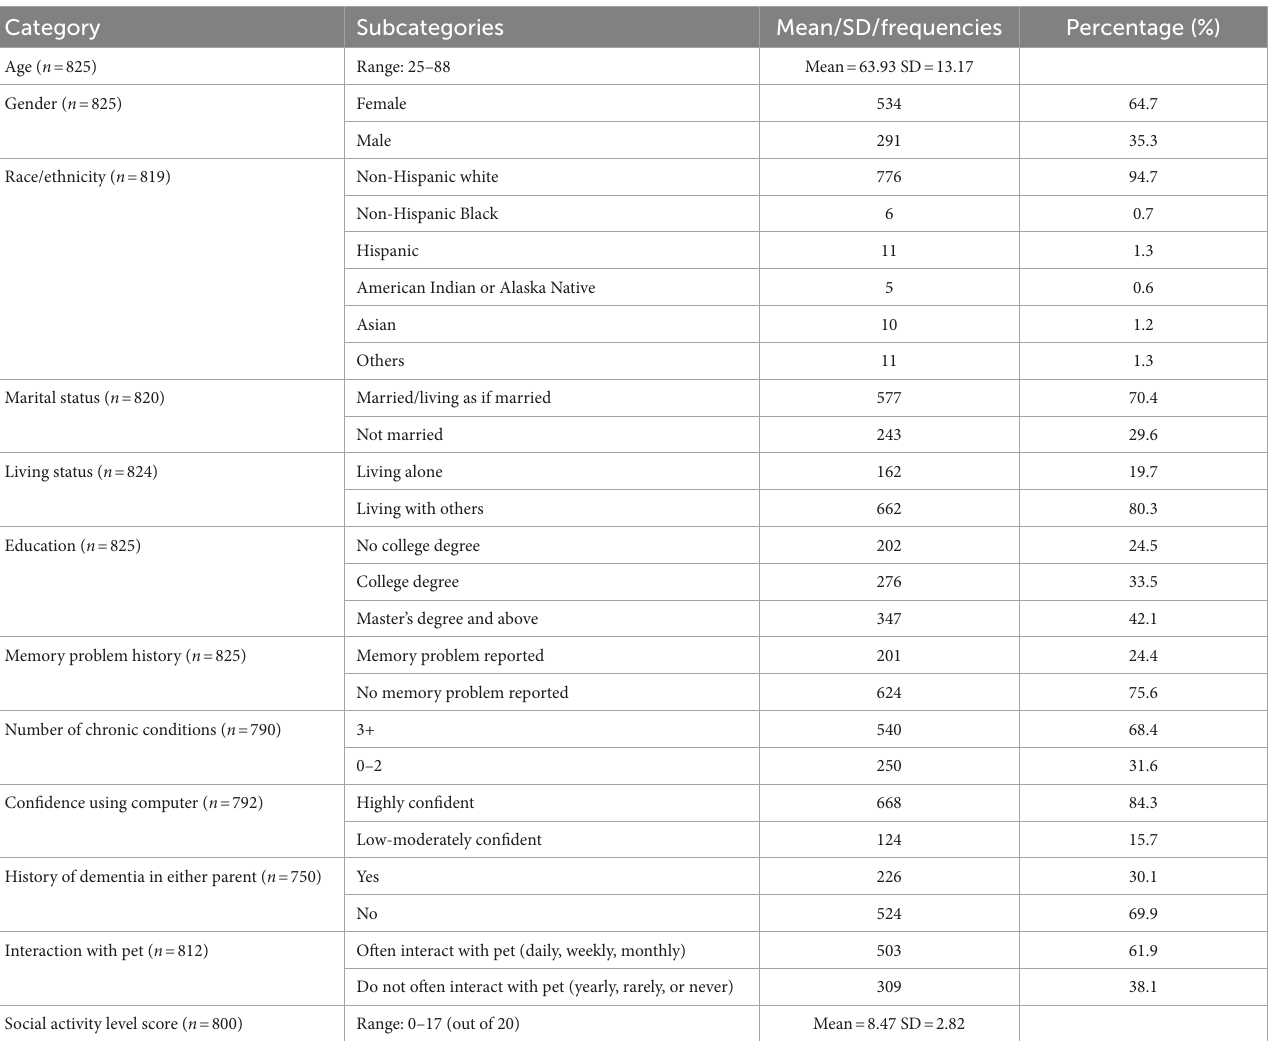
TABLE 1 Participant